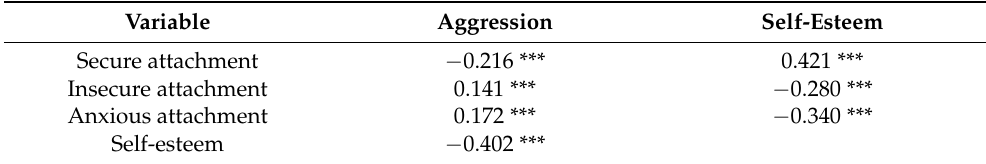
Table 3. Correlation between secure attachment, insecure attachment, anxious ambivalent attachment, self-esteem, and aggression.